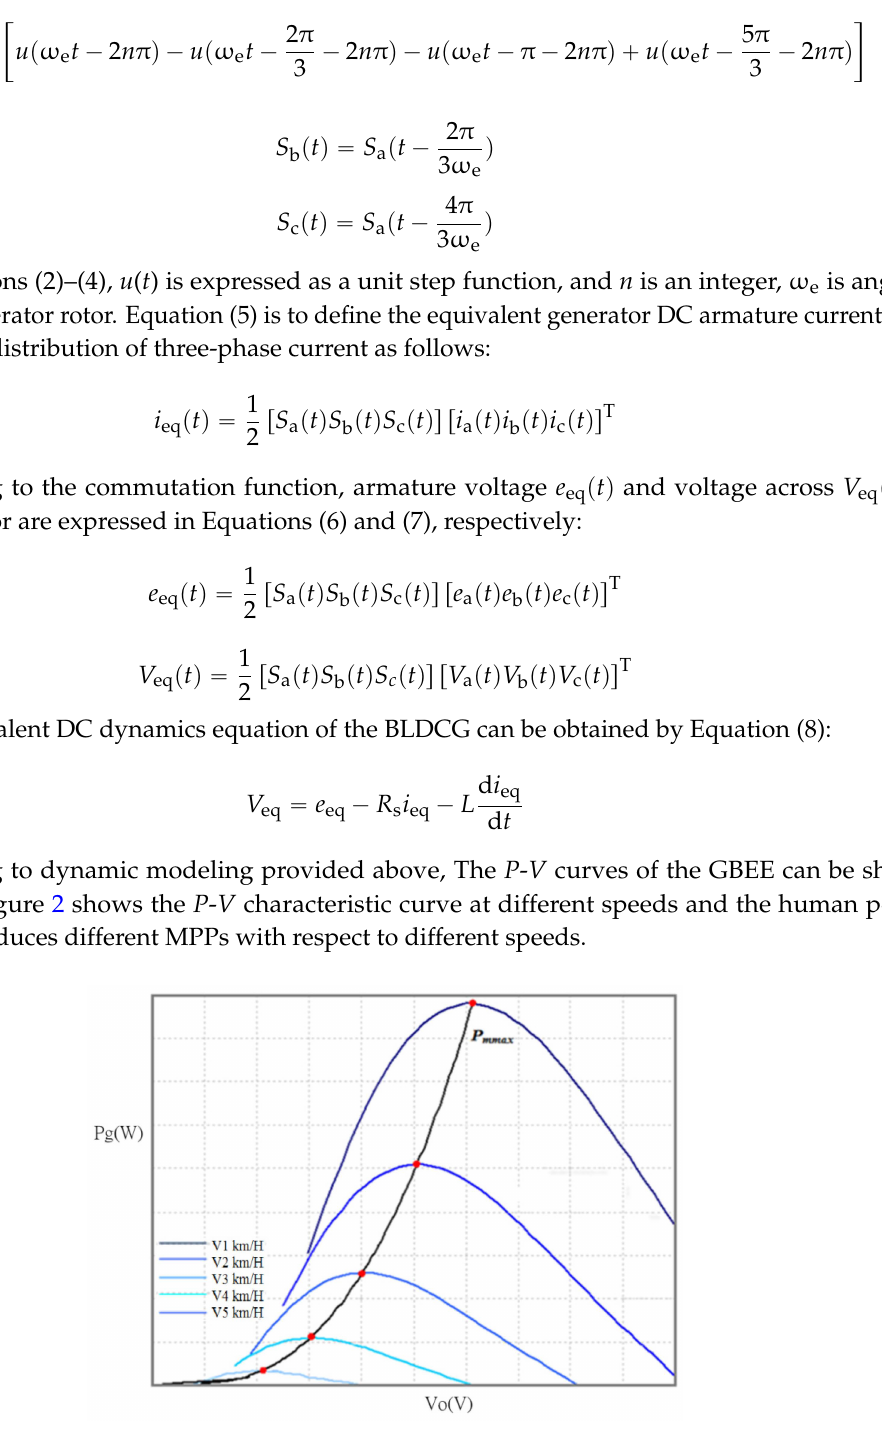
Figure 2. The P - V curves of generator-based exercise equipment